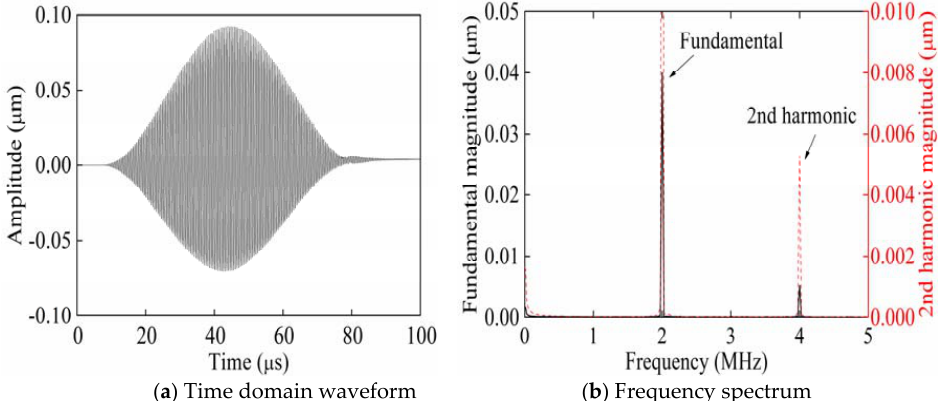
Figure 2. Time domain waveform and frequency spectrum of the received signals when exciting Rayleigh waves with a phase angle of 0° from P 1.